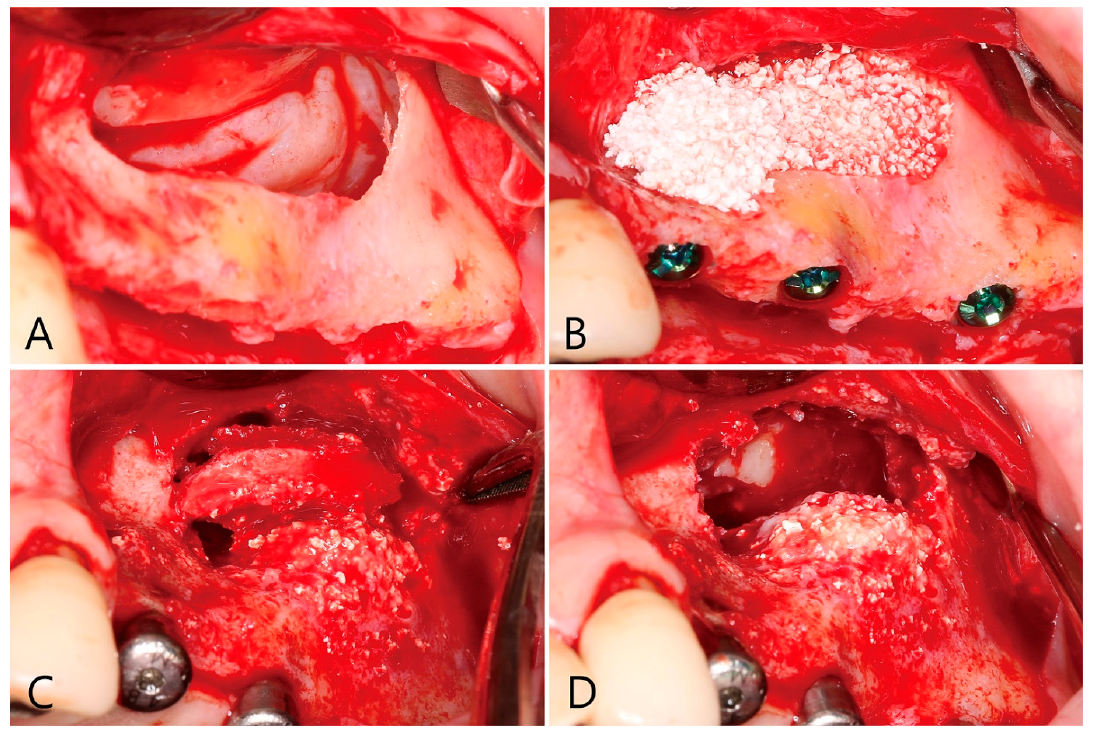
Figure 11. ( A ) The ovular lateral window was formed using a surgical round bur on the buccal bone. The Schneiderian membrane was detached from the sinus floor and elevated. No perforation of the Schneiderian membrane occurred; ( B ) biphasic calcium phosphate was mixed with physiological saline and placed in the maxillary sinus. Three implants were simultaneously placed; ( C ) six months after the MSA, when the buccal flap was reflected, the buccal bone which was interconnected with the void was removed. Healing abutments were inserted into the implants; ( D ) gentle debridement and saline irrigation were performed on the removed voided site. The removed site was not refilled with a bone graft substitute.